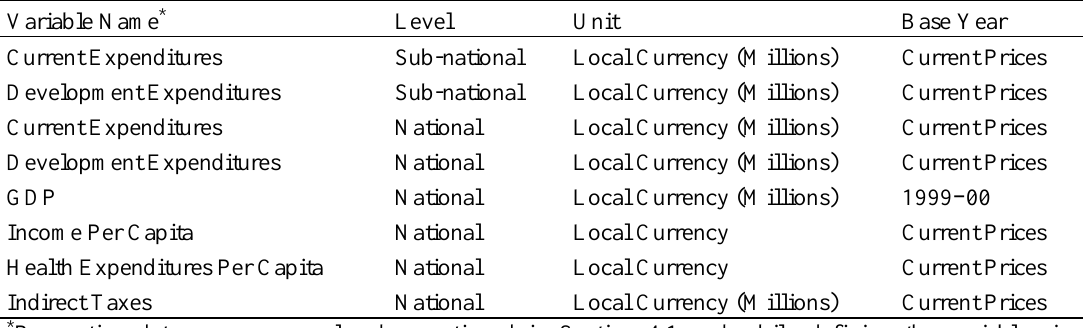
Table 2 : Units and Base Years of Monetary Variables